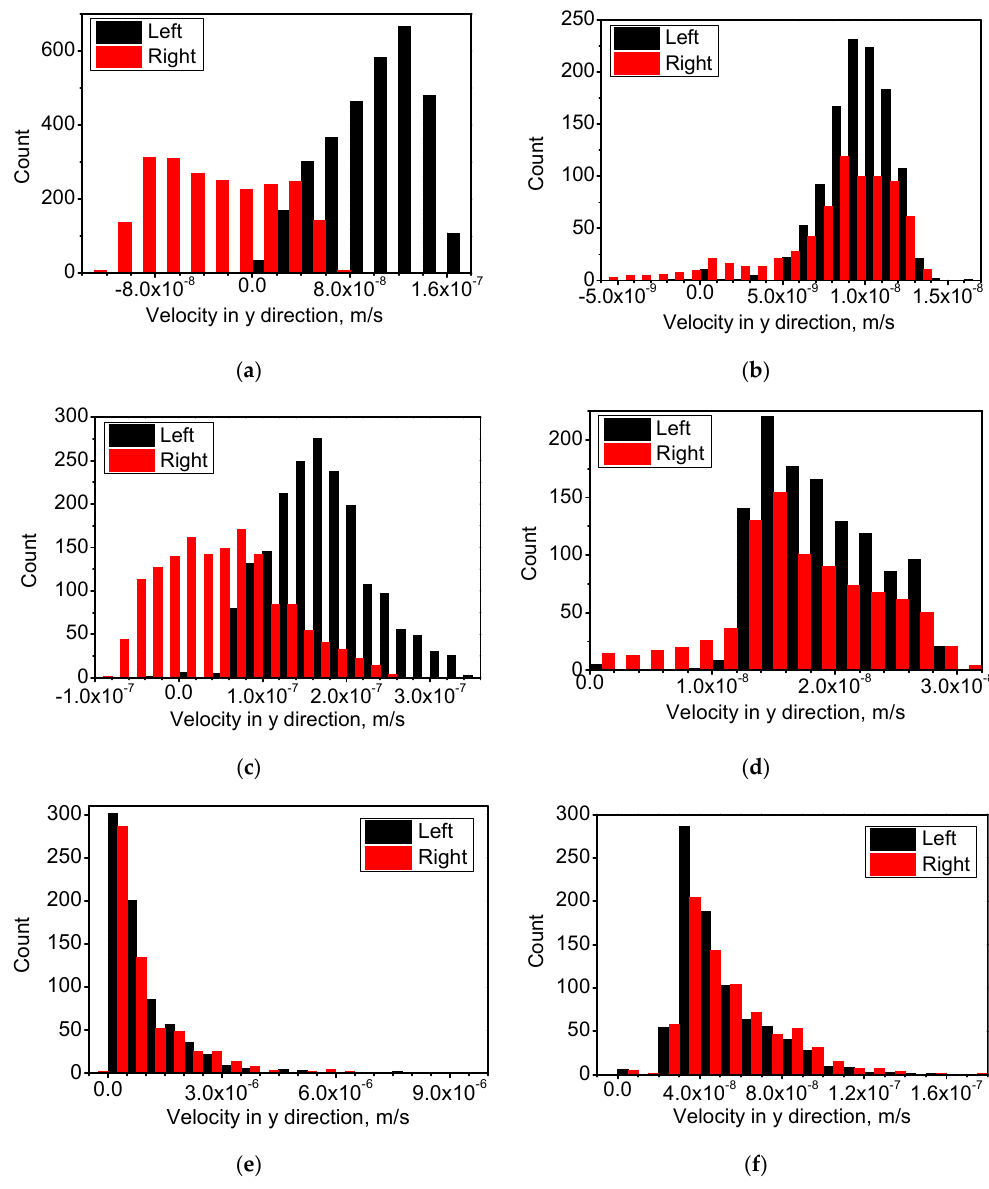
Figure 8. Comparison of migration velocity in the y direction of droplets in different size categories in both the left part and right part. ( a ) 0 T, 0.2 s, <20 μ m; ( b ) 12 T, 2 s, <20 μ m; ( c ) 0 T, 0.2 s, 20–40 μ m; ( d ) 12 T, 2 s, 20–40 μ m; ( e ) 0 T, 0.2 s, >40 μ m; and ( f ) 12 T, 2 s, >40 μ m.